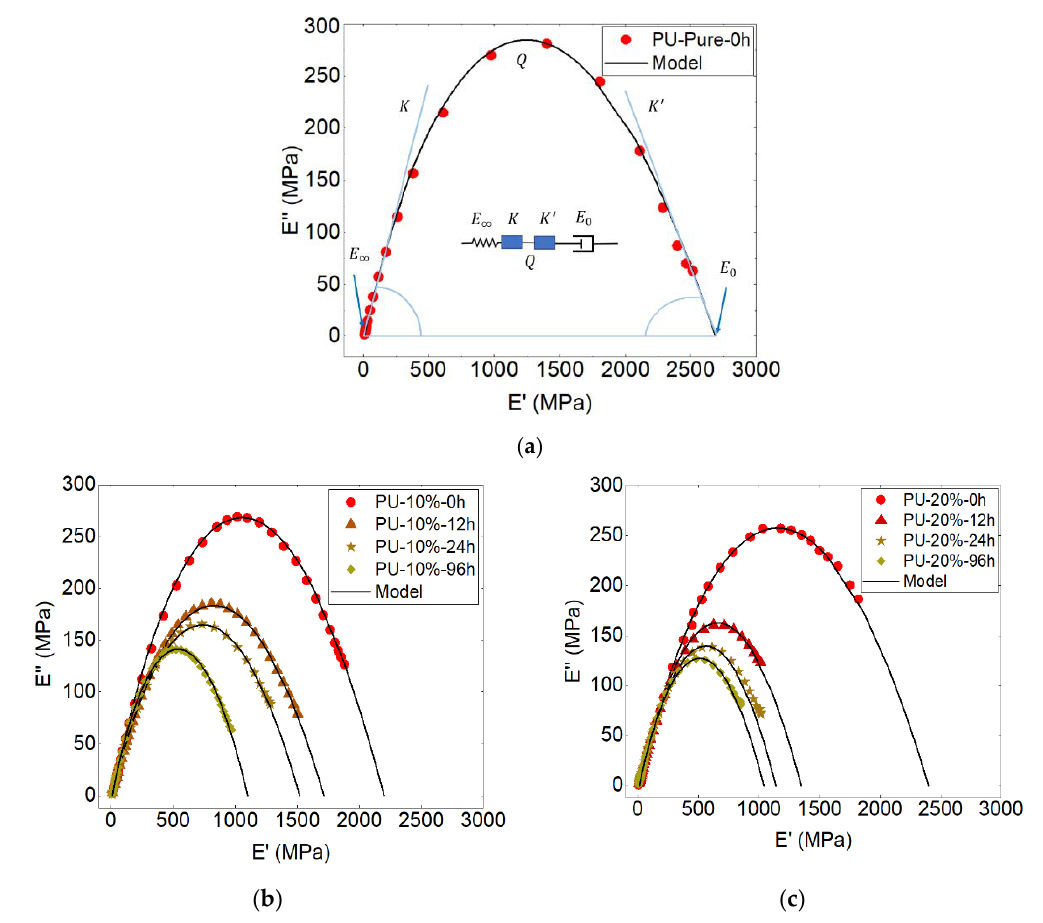
12 of 18 Figure 9. Flowchart diagram indicating the different steps of modeling (𝐸 ∗ : complex modulus, 𝐸 ′′ : loss modulus, 𝐸′ : storage modulus, 𝛿 phase lag between stress and strain). The polarization magnitude of a material is defined by the dielectric constant repre- sented by the equations of Debye and Onsager [38]. The single relaxation peak is inappro- priate to reasonably describe the viscoelastic behavior of polymers. Cole–Cole is an ap- propriate treatment of dielectric relaxation data marked by plotting 𝐸′′ versus 𝐸′ [39];